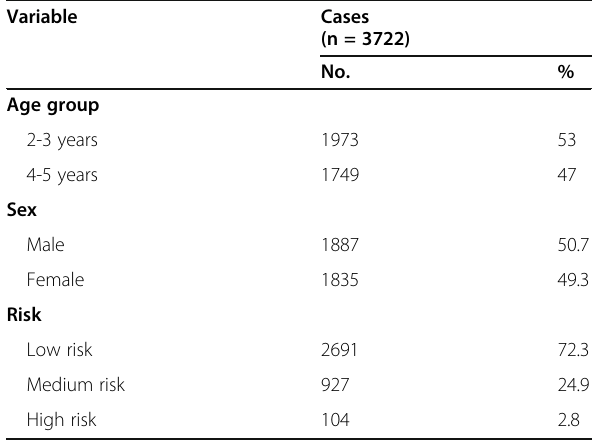
Table 1 Demographic and clinical characteristics of the studied group Variable Cases